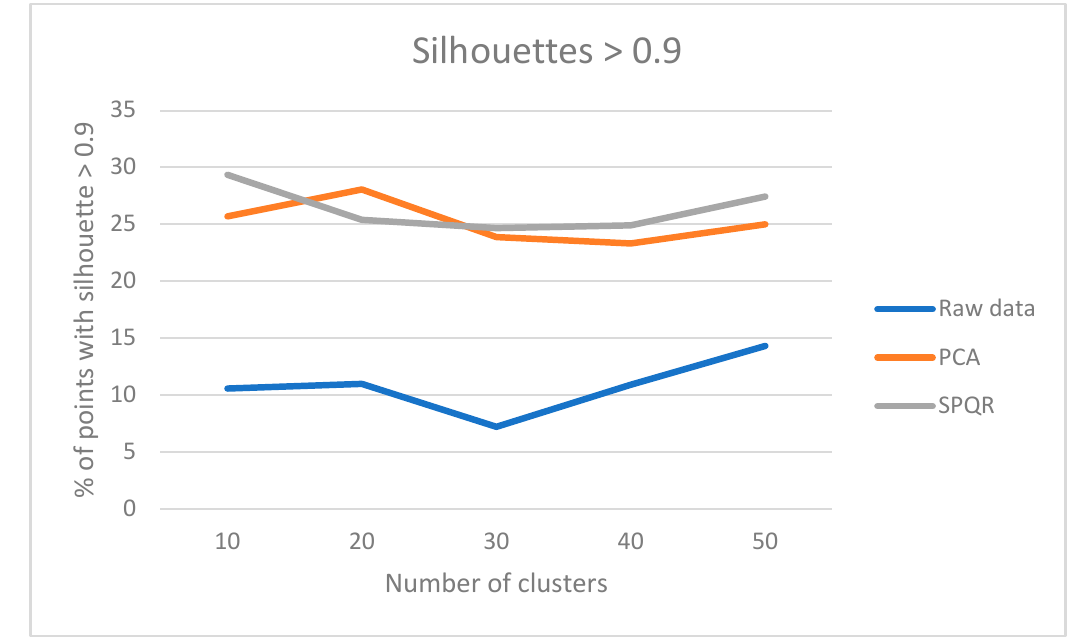
Figure 3. Mean results in terms of silhouettes >0.9 obtained by varying the number of clusters from 10 to 50.